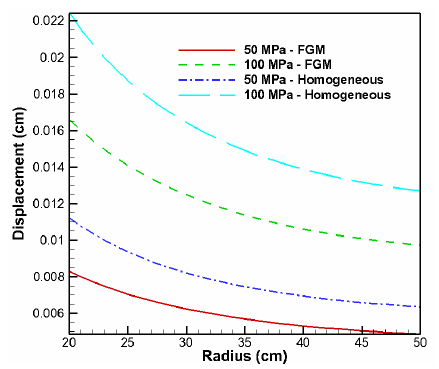
= 50 MPa, 𝑇 𝑖 𝑇 = 0 𝑜 𝐶 , 𝑇 = 500 𝑜 𝐶 and 𝜔 = 350 rad/s 𝑟𝑒𝑓 𝑟 𝑜